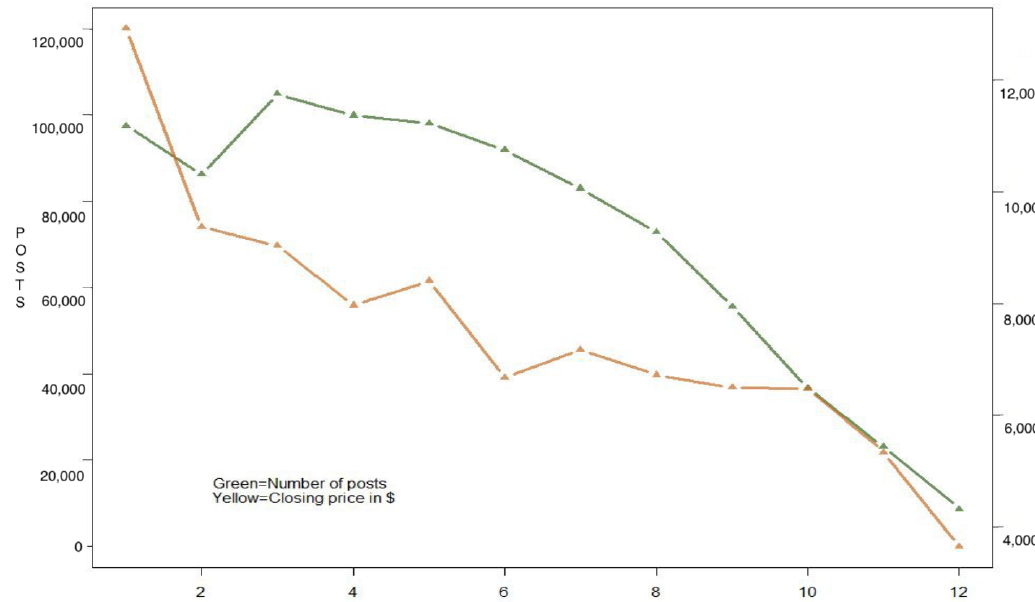
Figure 7. Nominal comparison between the monthly number of posts and the closing value in 2018.